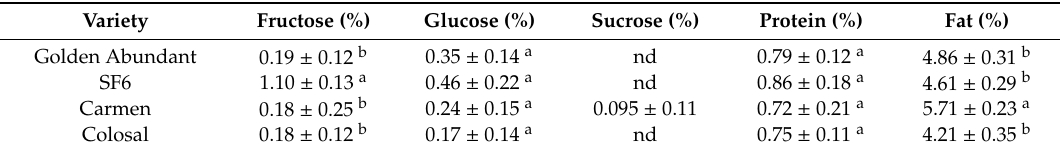
Table 1. Total sugar, protein, and fat content of sea buckthorn